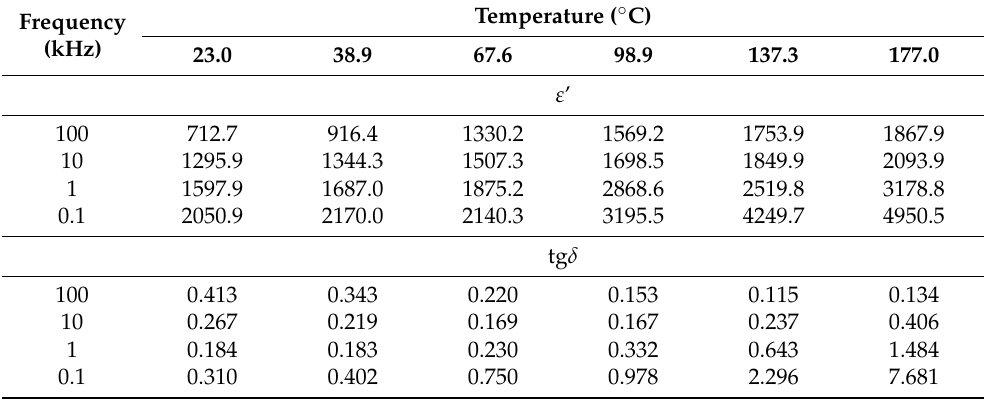
Figure 9. Frequency − dependent dielectric constant ε ’ of the CCTO ceramic at different temperatures. It is obvious that CCTO materials possess a high dielectric permittivity ε ’ (>10 3 ) which significantly depends on temperature and frequency (Table 5). Table 5. The frequency and temperature dependence of the dielectric constant ( ε ’) and the dielectric loss (tg δ ) for CCTO